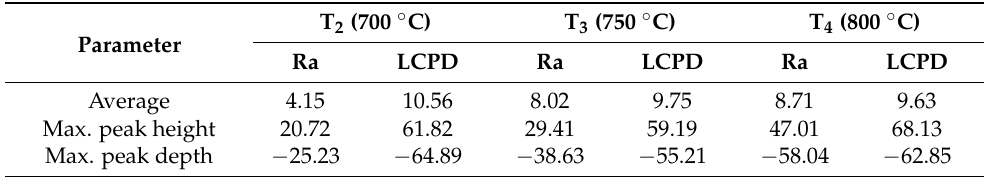
Table 1. Surface roughness (Ra, nm) and local contact potential difference (LCPD, mV) of T 2 , T 3, and T 4 samples for different growth temperatures.